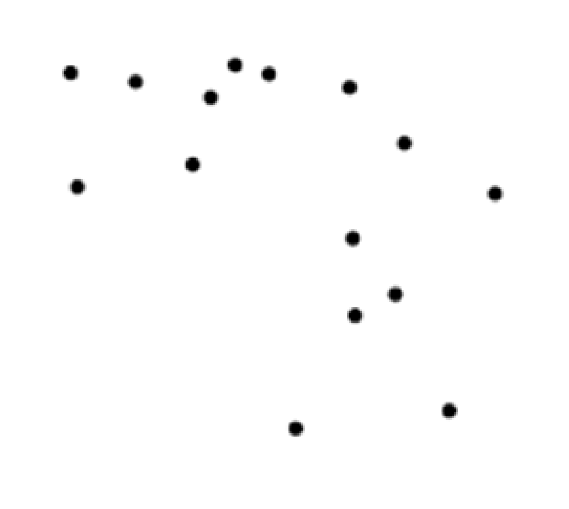
Figure 7: Scattered points (Kevin, 2008) The following constructions mapped the unit interval to a unit square of the Hilbert’s curve